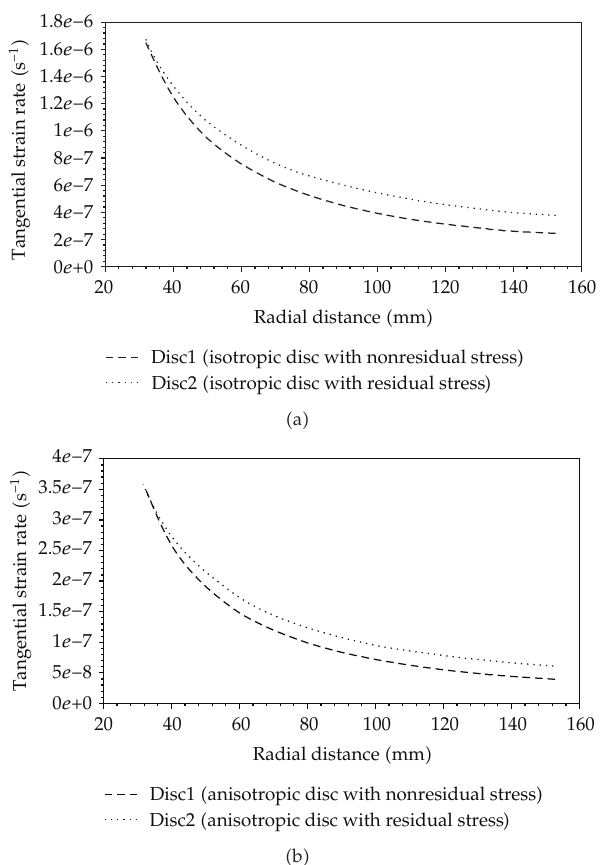
Figure 5: Variation of tangential strain rate along the radial distance in isotropic/anisotropic discs rotating with an angular velocity 15000rpm at